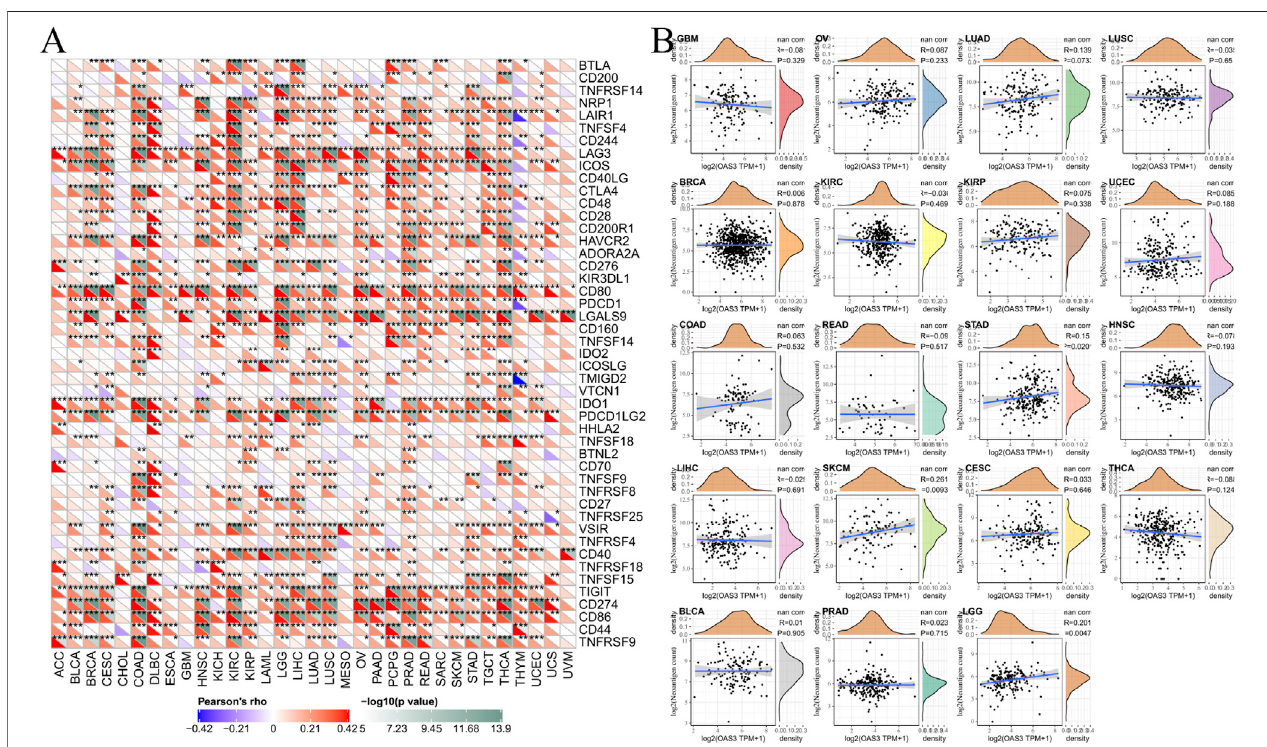
FIGURE 6 | (A) The correlation between OAS3 expression and immune checkpoint genes in pan-cancer. Each square corresponded to the correlation between OAS3 expression and the expression of one immune checkpoint gene in a particular tumor. The upper triangle of each square represented the magnitude of the p value of thecorrelationtest, and the lower triangle represented the correlation coef fi cient ( p p < 0.05, pp p < 0.01, ppp p < 0.001). (B) ThecorrelationbetweenOAS3expression and neoantigens.